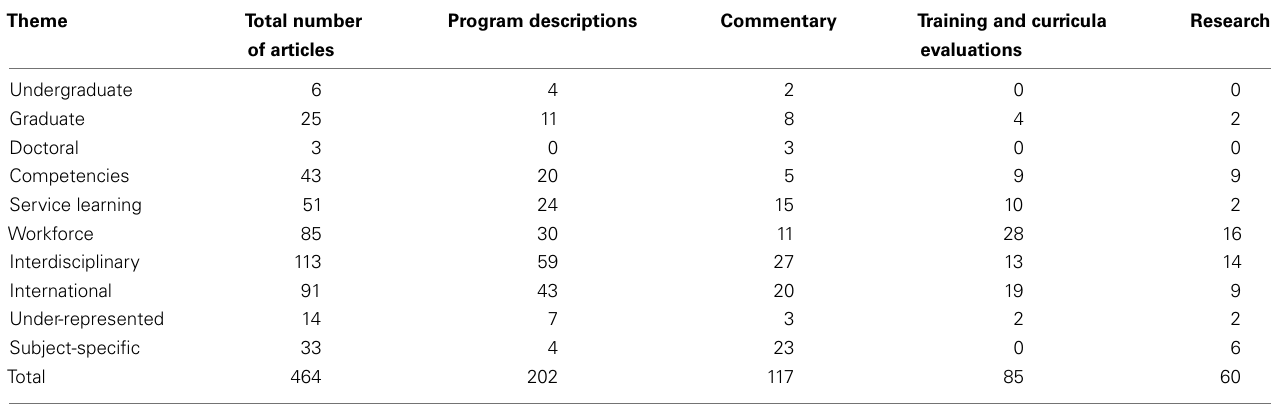
Table 3 |Articles pertaining to the pedagogy of public health professionals education by theme and type